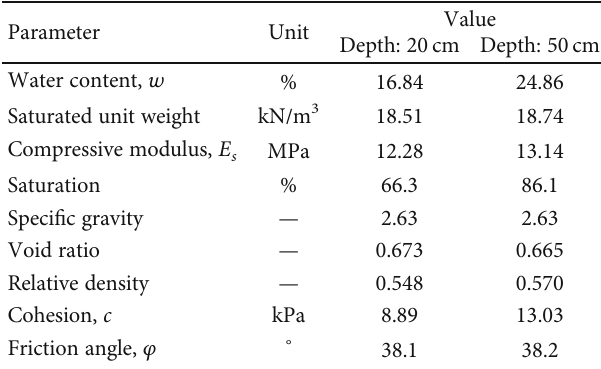
Table 2: Properties of consolidated saturated sand.